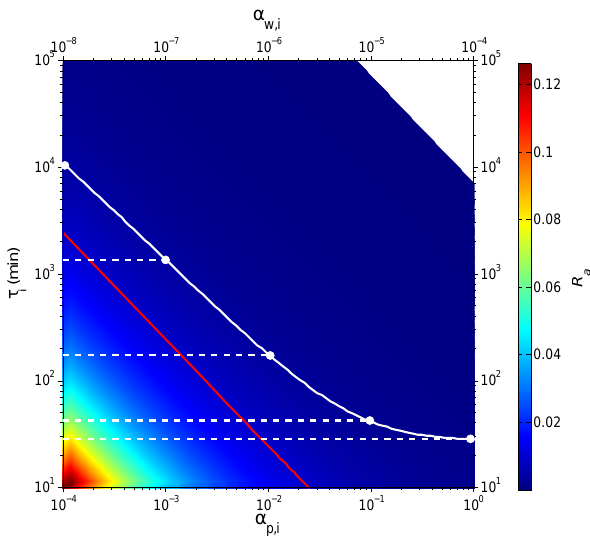
Figure 8. Comparison of estimated gas-particle equilibration timescale ( τ g / p ,i ) as a function of the gas-particle mass accommo- dation coefficient ( α p ,i , lower x axis) and the ratio of total particle surface area to the chamber wall area ( R a , color bar), and vapor wall deposition timescale ( τ g / w ,i ) as a function of gas–wall mass accom- modation coefficient ( α w ,i , upper x axis). The red solid line repre- sents the gas-particle equilibration time for a typical chamber exper- iment with seed surface area of ∼ 1 × 10 − 3 µm 2 cm − 3 . White solid and dashed lines define the region where τ g / p ,i ∼= τ g / w ,i . For exam- ple, the top dashed white line is a collection of data points for which the equality τ g / p ,i = τ g / w ,i = 1 . 3 × 10 3 min holds. τ g / w ,i is calcu- lated by substituting α w ,i = 10 − 7 into Eqs. (22), (23), and (24). τ g / p ,i is calculated from Eq. (27) by varying α p ,i (10 − 4 –10 − 3 ) and R a